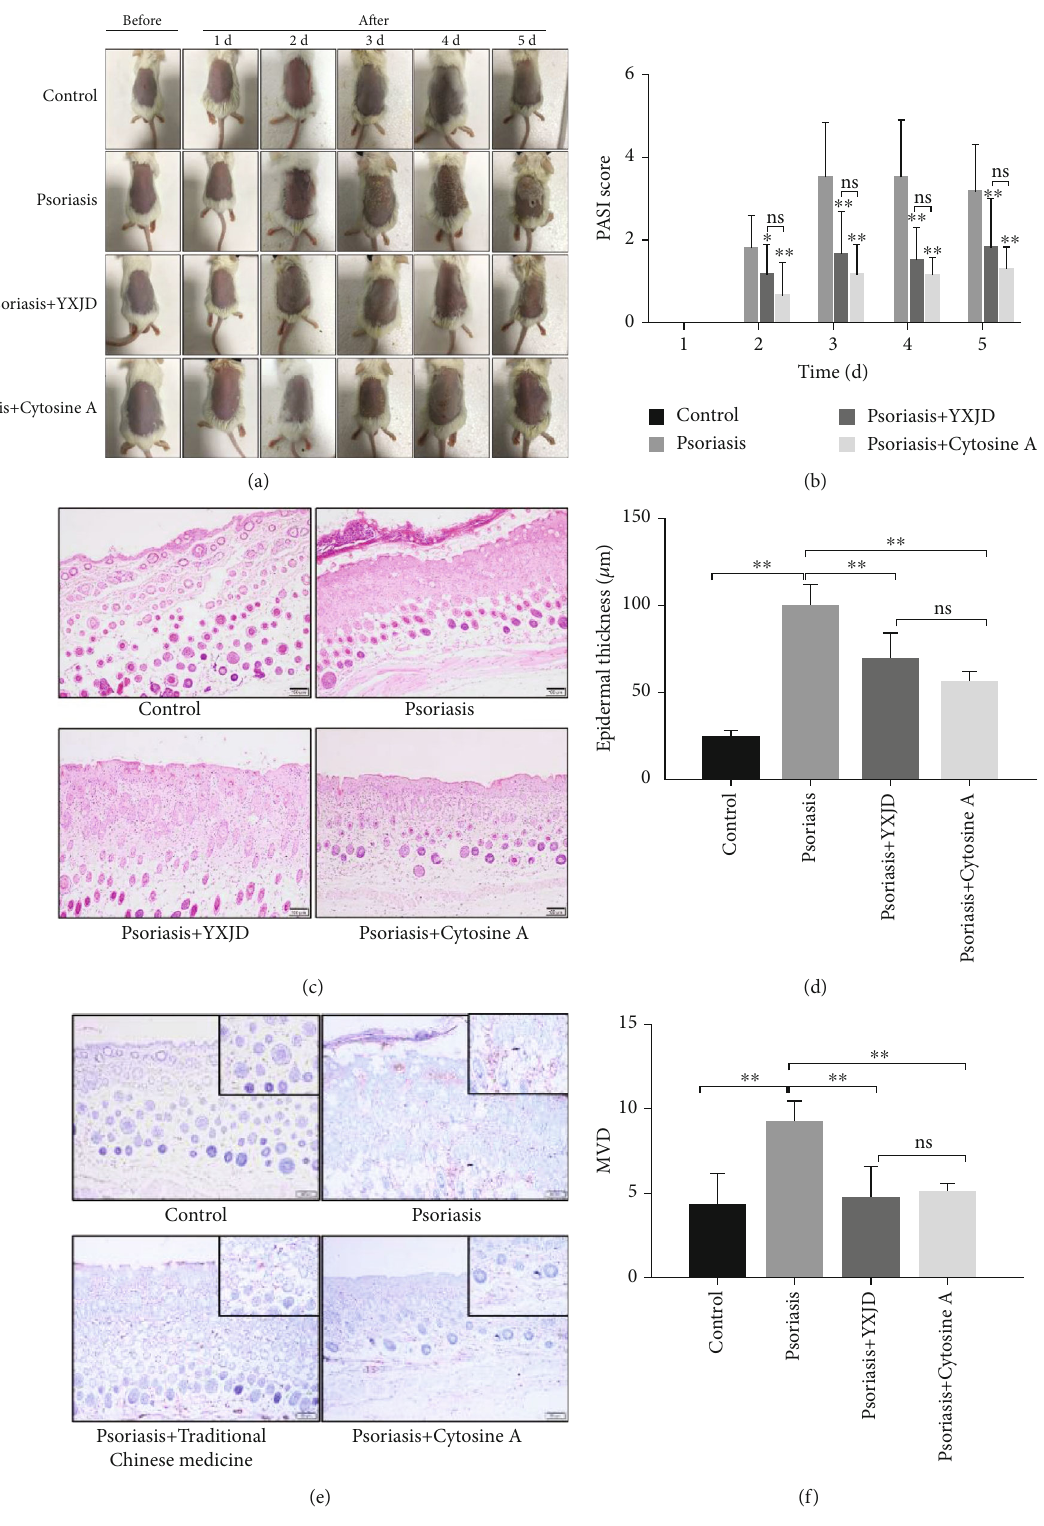
Figure 2: PASI scores, histomorphology, and MVD of the di ff erent groups. The e ff ect of YXJD on IMQ-induced psoriasis-like lesions in mice (a). The PASI scores of the mice were evaluated from the 2 nd day to the 5 th day after model construction, and the PASI scores of each group were compared (b). The lesion samples were stained with hematoxylin and eosin (HE) (c), and the thickness was determined for each group (d). The microvessel density (MVD) of the four groups (e) was detected by immunocytochemistry. Bar = 100 μ m . ∗ P < 0 : 05 vs. the model mice. The di ff erence in MVD among the 4 groups showed that MVD in the group treated with YXJD was reduced